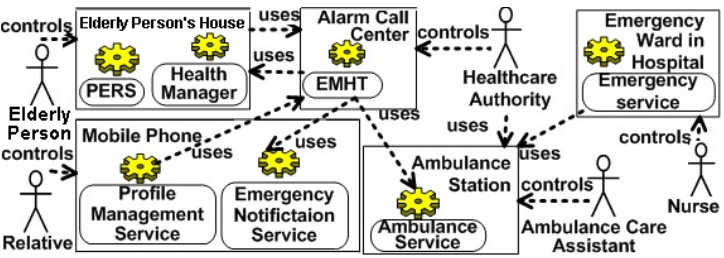
Figure 6. Part of the home monitoring system for handling healthcare cases inspired by